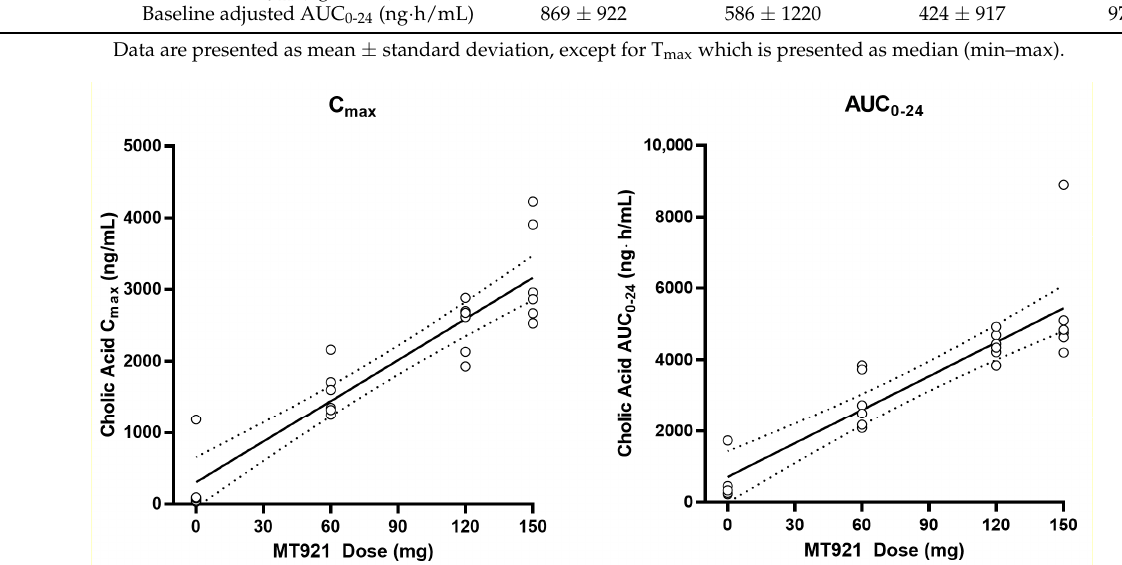
Figure 3. Relationship of pharmacokinetic parameters between cholic acid and deoxycholic acid.